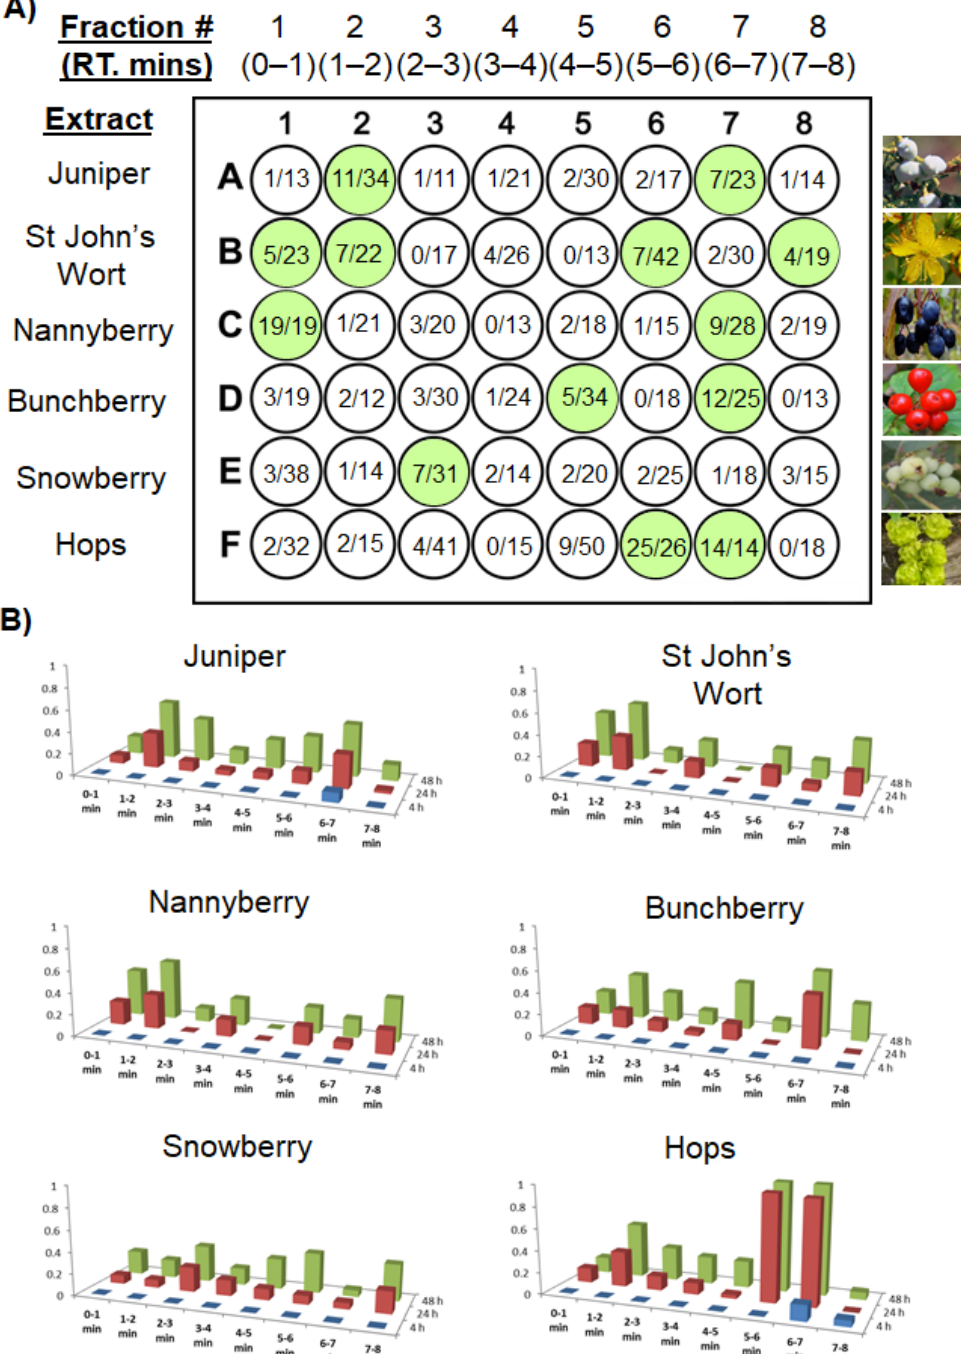
Figure 3. Representative bioassay screening data generated using UMSF technique. ( A ) Raw, individualized brine shrimp mortality data, taken at 24 h post exposure, highlighting active fractions; ( B ) averaged brine shrimp mortality data (n = 3), presented across time for UMSF derived samples; blue = 4 h exposure; red = 24 h exposure; green = 48 h exposure.